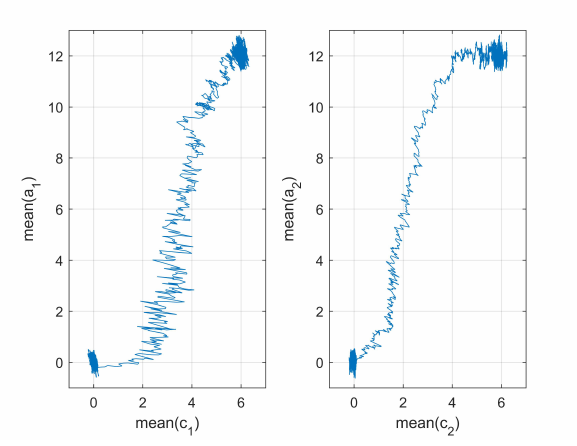
Figure 8: Step response phase portraits,